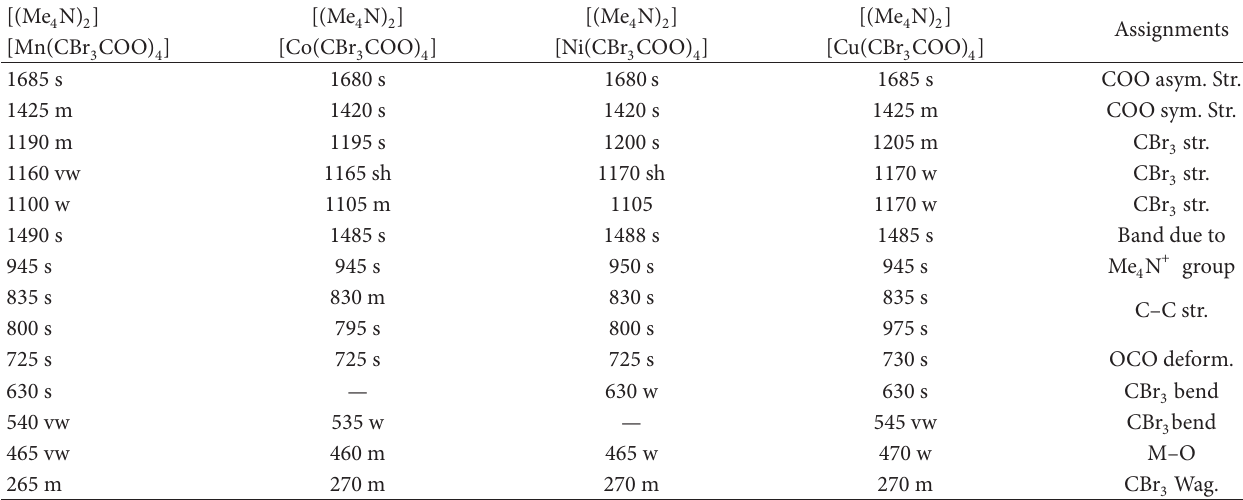
T 8: Infrared Spectral Bands (cm